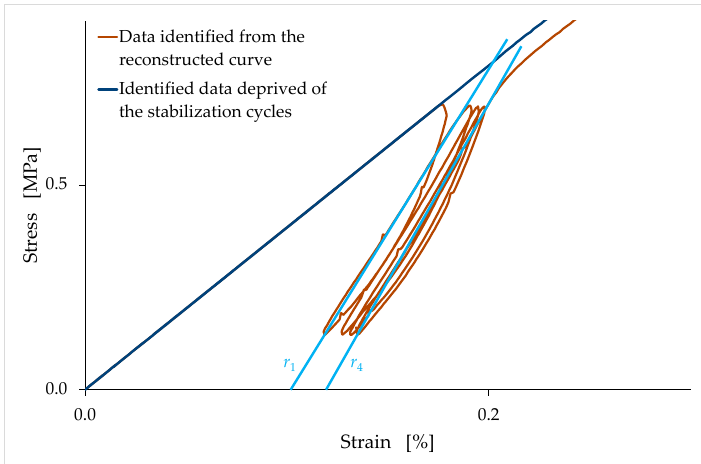
Figure 21. Evaluation of the average slope of unloading–reloading in a cycle as the slope of the straight line that joins the lower point of the cycle with the intersection point of the cycle.